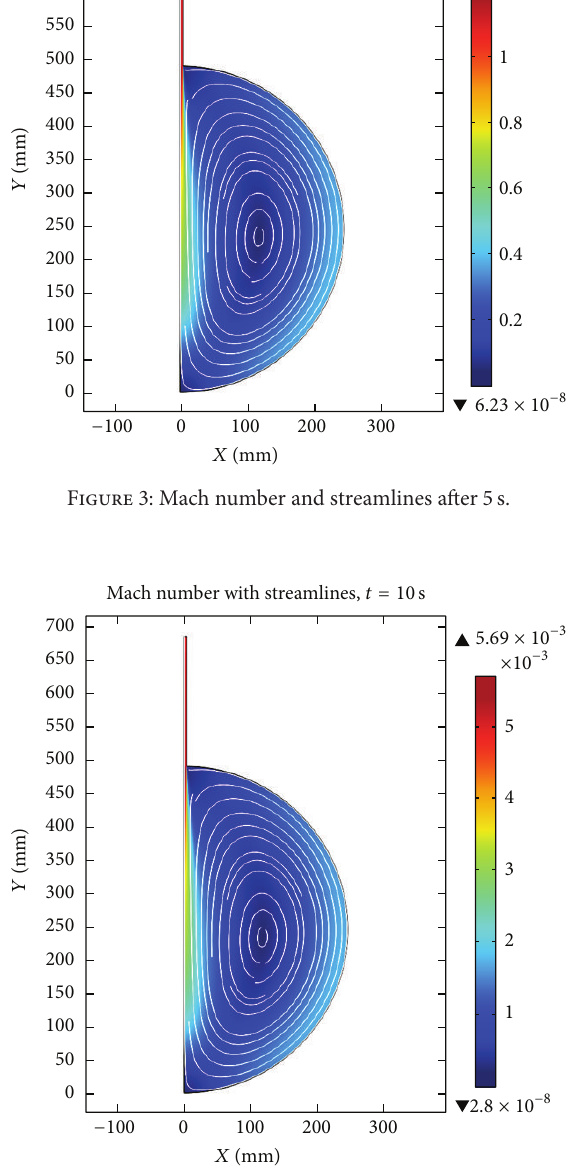
Figure 4: Mach number and streamlines after 10s.